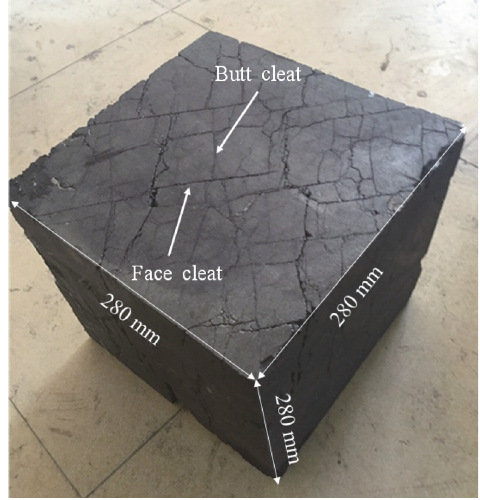
Figure 1: Cleat structure of coal at surface conditions.